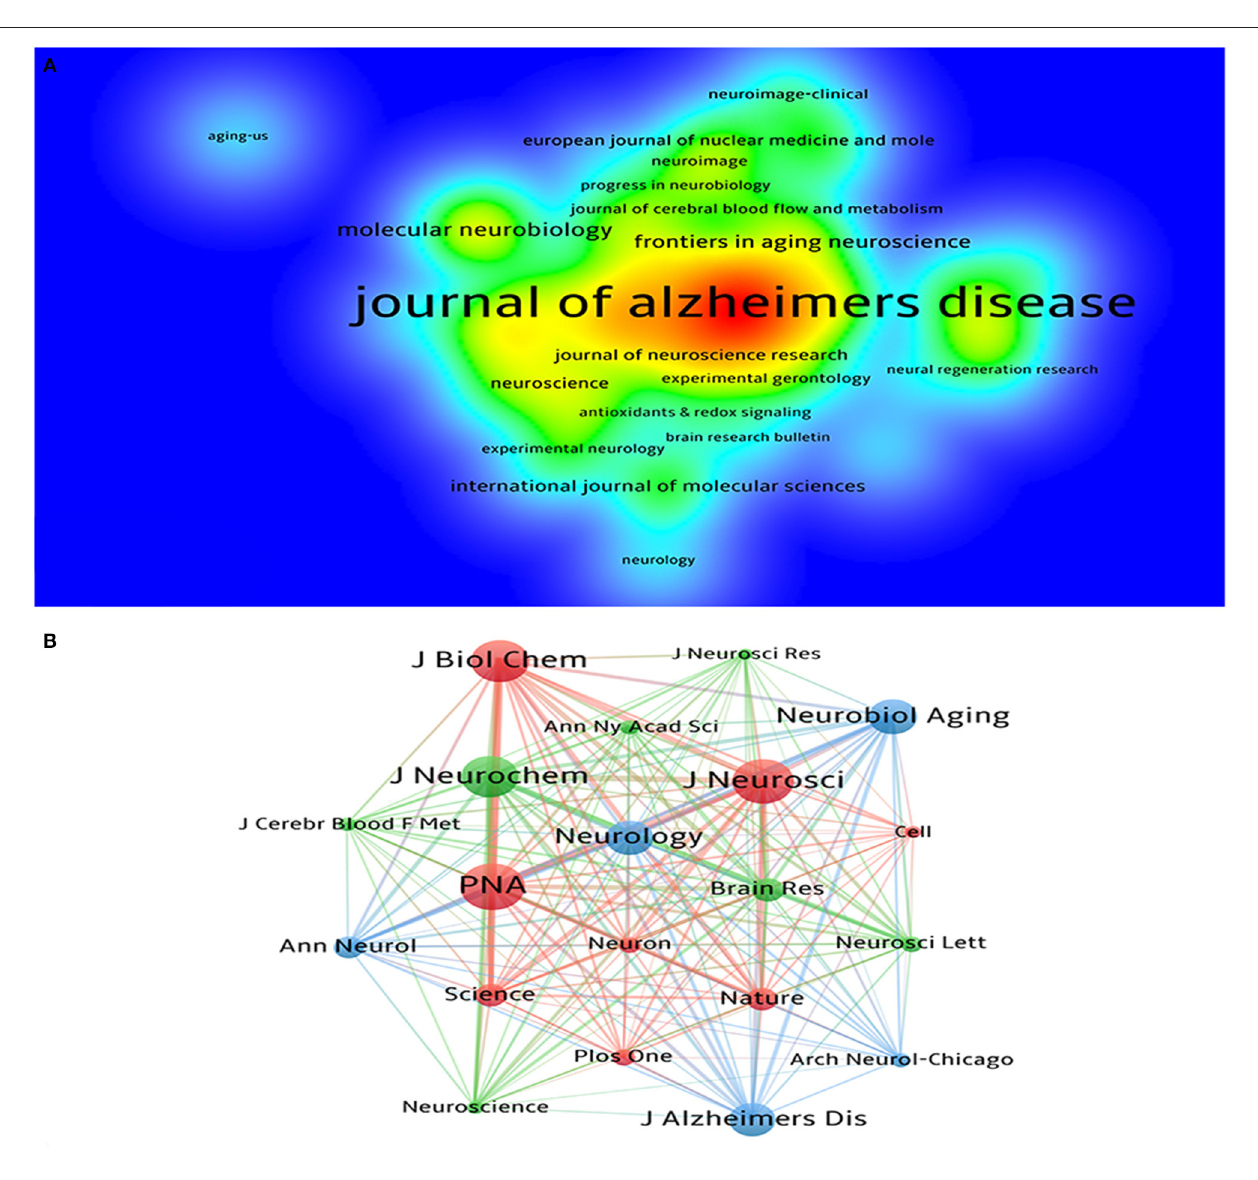
FIGURE 4 | (A) The density visualization map of journals based on VOSviewer; (B) The co-citation network visualization map of journals based on VOSviewer.